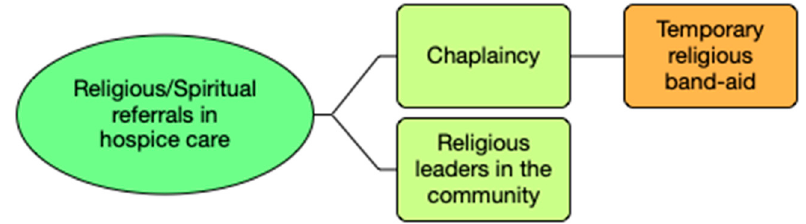
Figure 1. Responding to religious/spiritual needs via referrals.